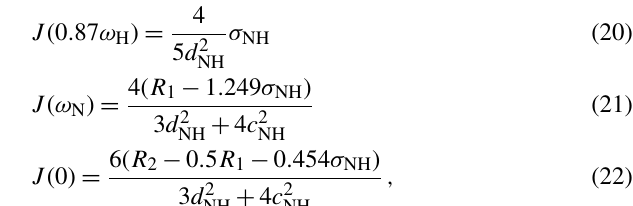
vidual Y ∗ , Y ∗ , and Y ∗ vectors from the table. With 4 j 10 j 6 j